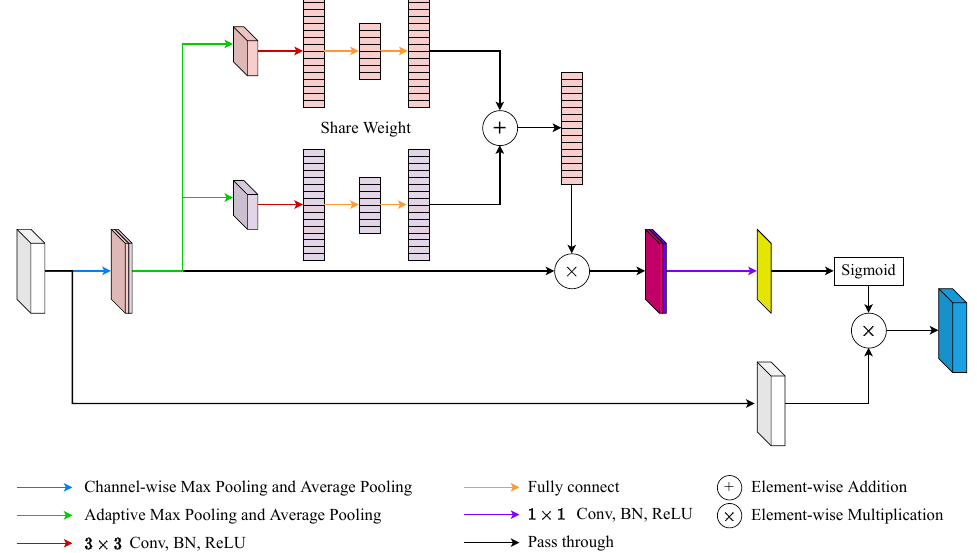
Figure 4. An illustration of scale attention (SA). SA addressed the defects of convolutional block attention module (CBAM) by adaptive channel pooling and squeeze-and-excitation (SE)